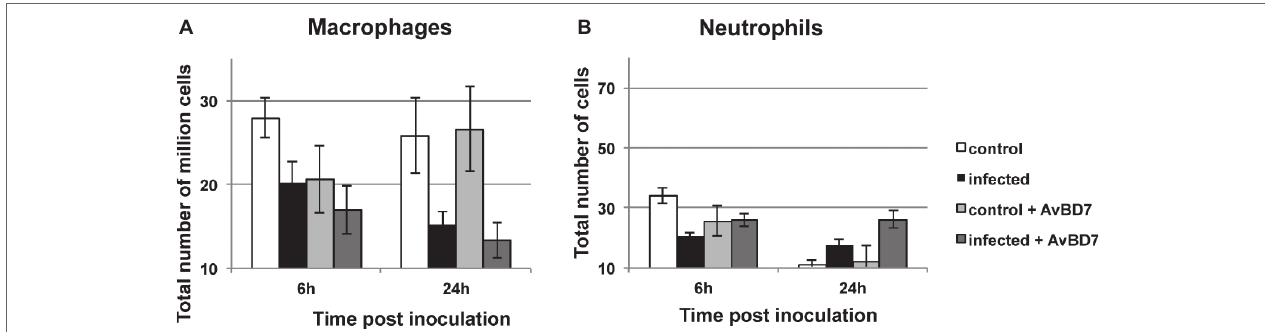
FIGURE 5 | Peritoneal cell counts in mice infected or not with S. Typhimurium and treated or not with AvBD7, after 6 or 24 h. BALB/c mice were inoculated or not with S. Typhimurium and were treated or not with AvBD7, as indicated in the Materials and Methods section. Peritoneal monocytes/macrophages (A) or neutrophils (B) numbers from non-infected and non-treated animals are represented by white bars; infected and non-treated animals are represented by black bars; non-infected and treated animals are represented by light grey bars; infected and treated animals are represented by dark grey bars. Values are given as mean total number of million macrophages or as mean total number of neutrophils ± standard error of the mean ( n = 10).